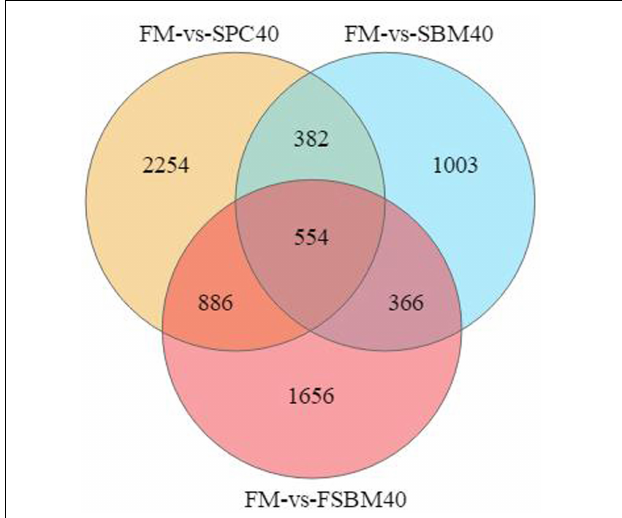
FIGURE 8 | Venn diagram analysis of the significantly differentially expressed genes (DEGs) of the soy protein substitutes for fish meal in the distal intestine of the pearl gentian grouper ( n =